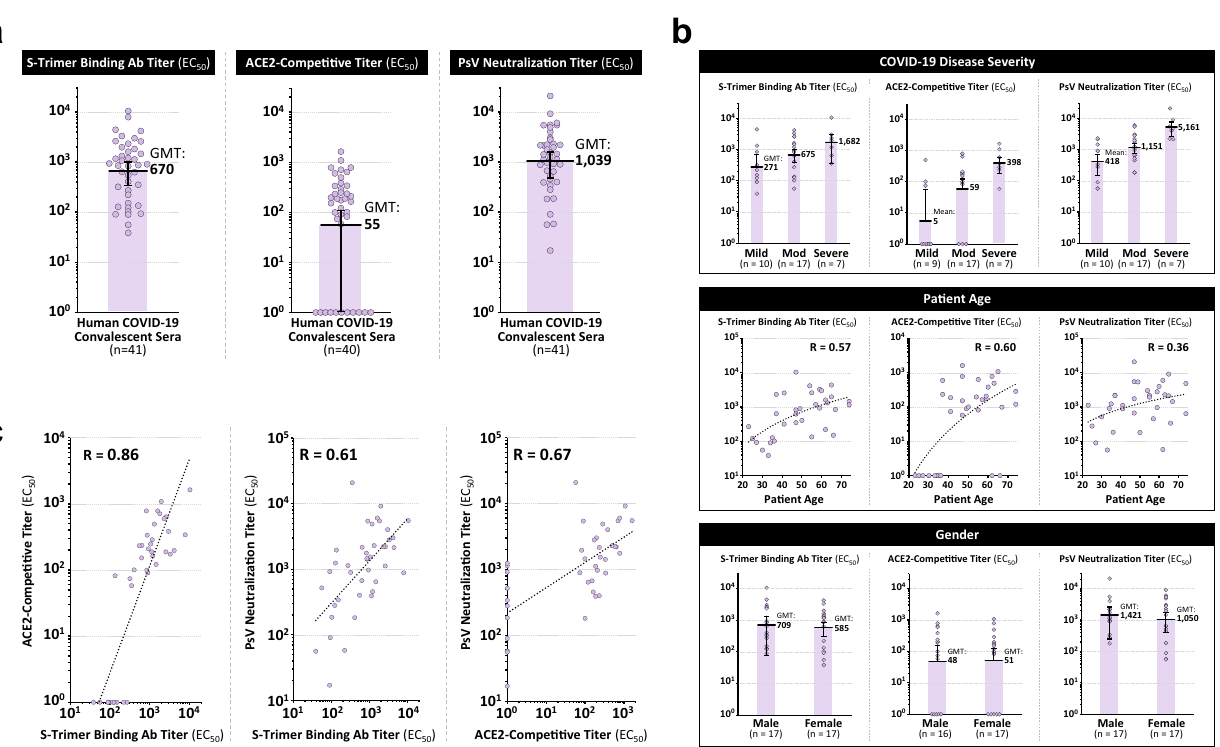
Fig. 2 Detection of SARS-CoV-2 spike binding and neutralizing antibodies in human COVID-19 convalescent sera. 41 human convalescent sera collected from recovered COVID-19 subjects were analyzed for a S-Trimer binding antibody titers, ACE2-competitive titers, and pseudovirus neutralization titers. b Antibody titers were strati fi ed based on patient COVID-19 disease severity, patient age, and gender in 34 subjects where such information was available. c Antibody titers in the human convalescent sera for the three assays (S-Trimer binding antibodies, ACE2-competitive, and pseudovirus neutralization) were analyzed for correlation by using two-tailed Pearson ’ s R analysis. Points represent individual humans; horizontal lines indicate geometric mean titers (GMT) of EC 50 for each group